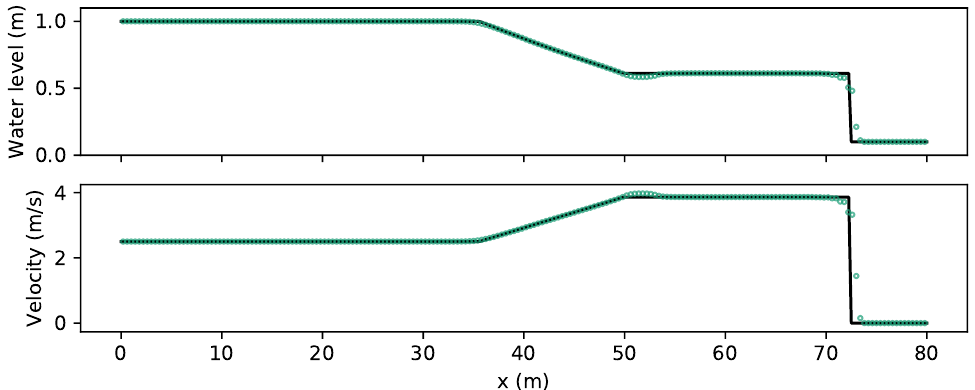
Figure 8. Analytical (black lines) and numerical (green circles) solution for Riemann problem.